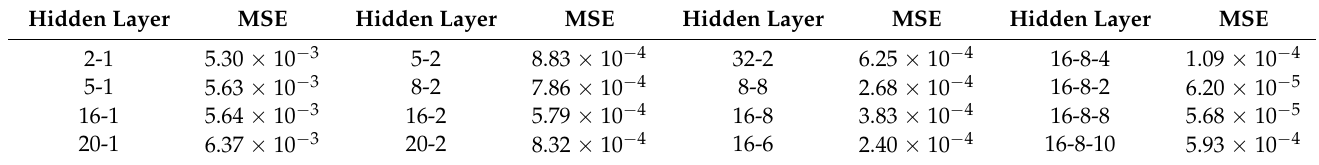
Table 1. The hidden layer and its corresponding mean square error (MSE) value.